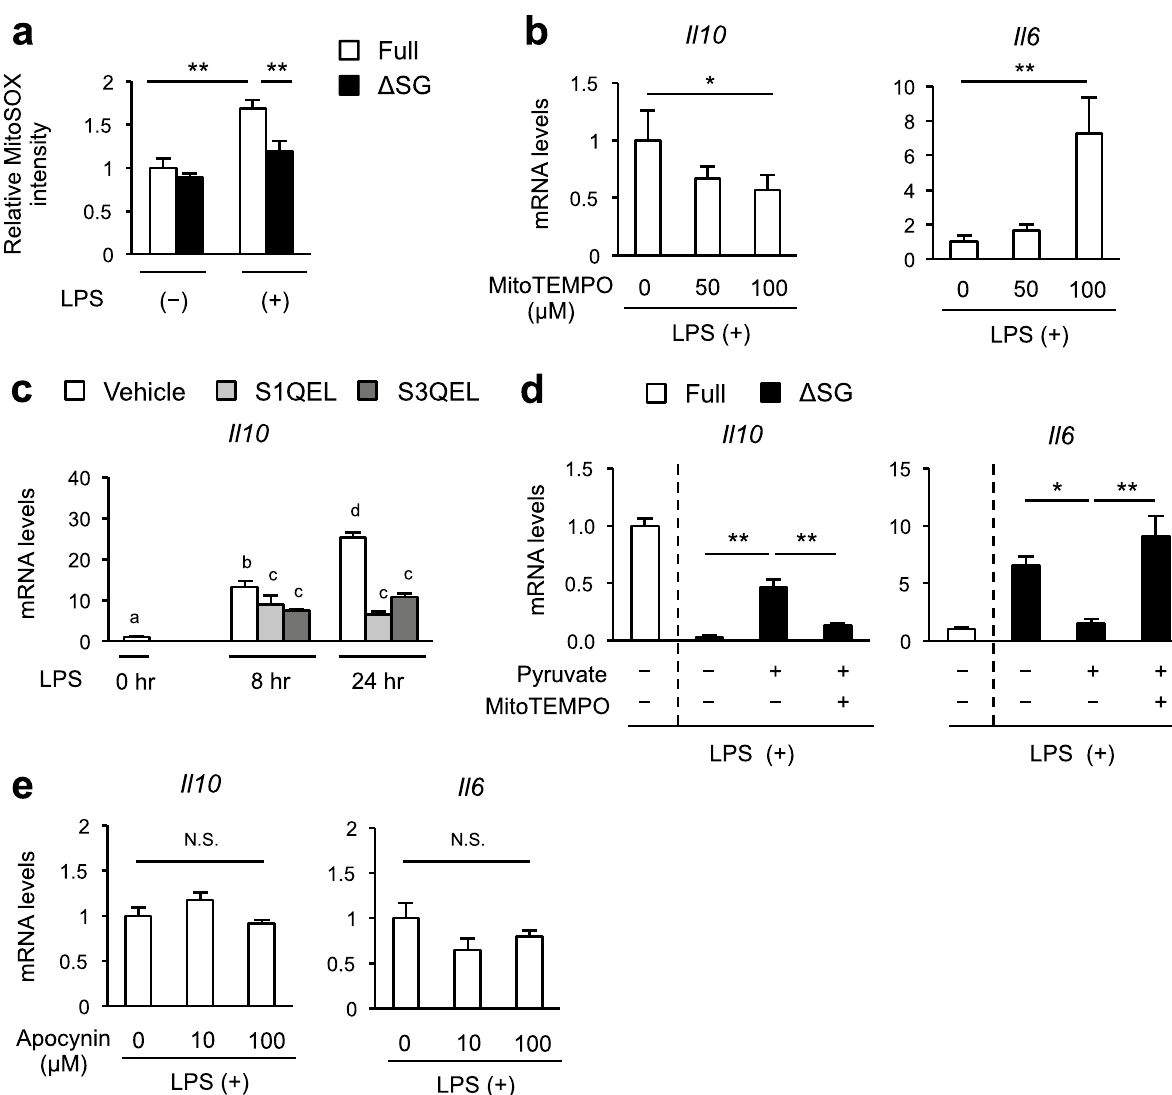
Figure 6. Impaired production of mitochondrial ROS by serine and glycine deprivation is a cause of aberrant cytokine expression. ( a ) Flow cytometry analysis of mitochondrial ROS production in BMDMs using MitoSOX (a mitochondrial superoxide indicator). BMDMs were cultured in Full or ∆SG medium for 24 h, followed by stimulation with LPS (100 ng/ml) for 8 h (n = 4). ( b ) Gene expression of Il10 and Il6 in BMDMs. BMDMs were cultured in Full medium with the indicated concentrations of MitoTEMPO (a mitochondria-targeted superoxide dismutase) for 24 h, followed by stimulation with LPS (100 ng/ml) for 24 h (n = 4). ( c ) Gene expression of Il10 in BMDMs. BMDMs were cultured in Full medium for 24 h, treated with S1QEL or S3QEL (suppressors of complex 1 and 3, respectively) for 24 h, and then stimulated with LPS (100 ng/ml) for 8 h or 24 h (n = 4). ( d ) Gene expression of Il10 and Il6 in BMDMs. BMDMs were cultured in Full or ∆SG medium with pyruvate (10 mM) and/or MitoTEMPO (100 µM) for 24 h, followed by stimulation with LPS (100 ng/ml) for 24 h (n = 4). ( e ) Gene expression of Il10 and Il6 in BMDMs. BMDMs were cultured in Full medium for 24 h, treated with the indicated concentrations of apocynin for 1 h, then stimulated with LPS (100 ng/ml) for 8 h (n = 4). Values are means ± 95% CI. Statistical analysis was performed with Dunnett’s test ( a , b , d , e ) (compared to Full + LPS ( a ); Full + MitoTEMPO 0 µM ( b ); ∆SG + pyruvate + MitoTEMPO 0 µM ( d )) and Tukey–Kramer’s test ( c ) (suffixed superscript letters differ significantly, p < 0.05). * p < 0.05; ** p < 0.01; NS not